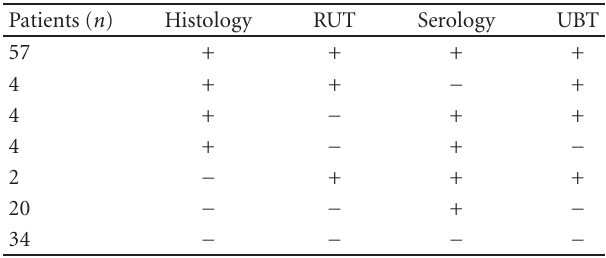
Table 1: Distribution of H. pylori diagnostic test discordant results. Patients ( n